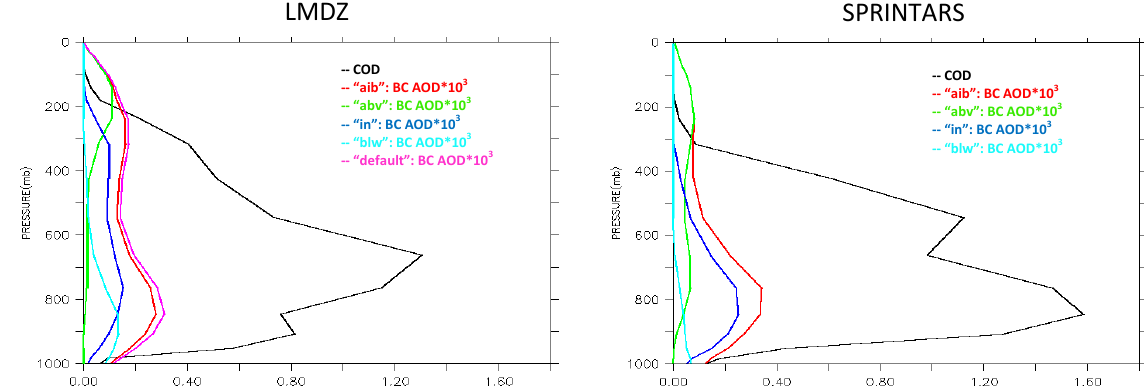
Fig. 6. Vertical profiles of BC and cloud optical depths (BC AOD and COD), for reading LMDz (left) and reading SPRINTARS (right) configurations, and AIB, ABV, IN , BLW experiments. In the left panel, for comparison, we also plot the vertical profile of BC AOD for the default 3-D distribution experiment (aerosols also in completely clear columns).